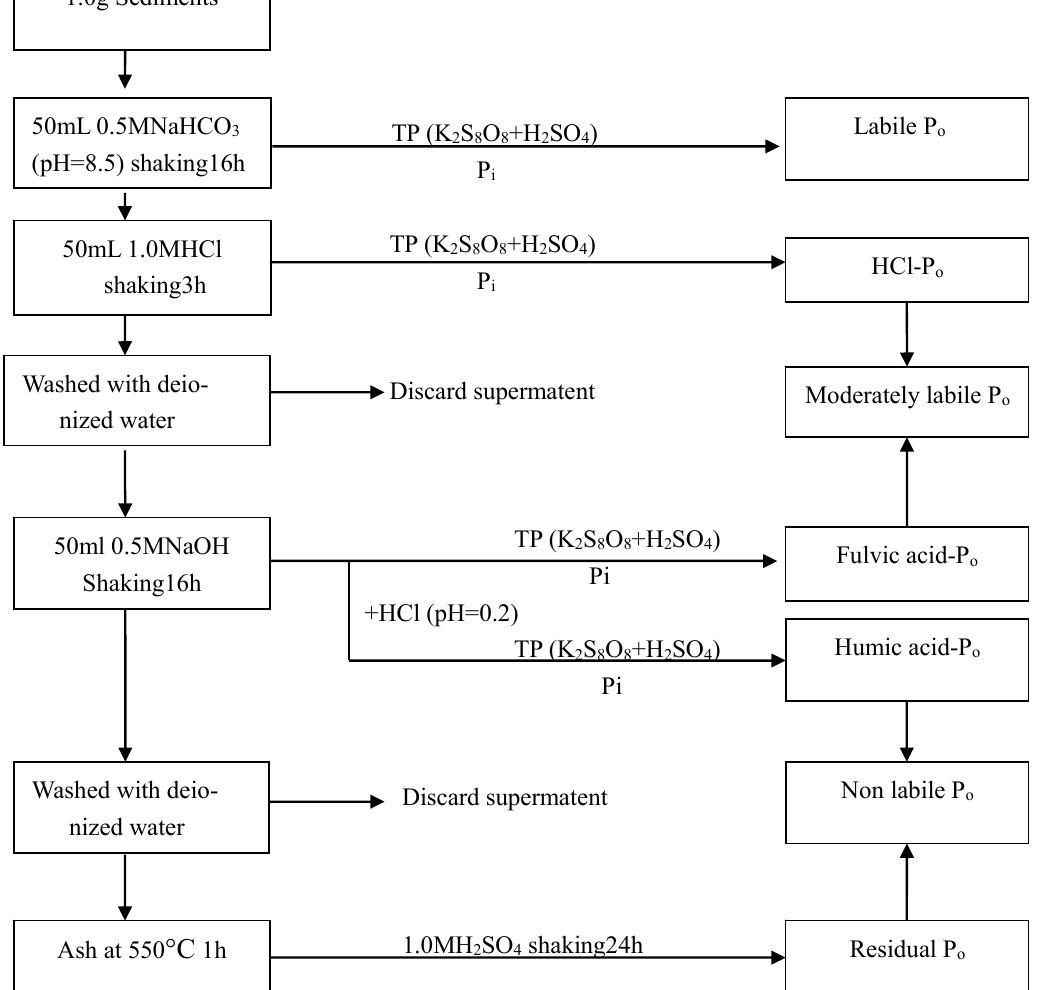
Figure 2. Fractionation procedure of organic phosphorus (Po) fractions in the